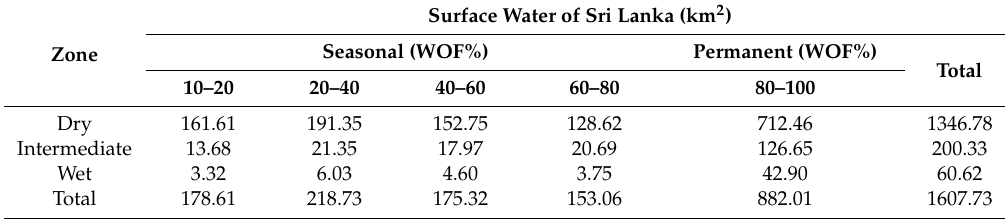
Table 3. Spatial distribution of water in climatic zones of Sri Lanka during the entire time-series (1988–2019).